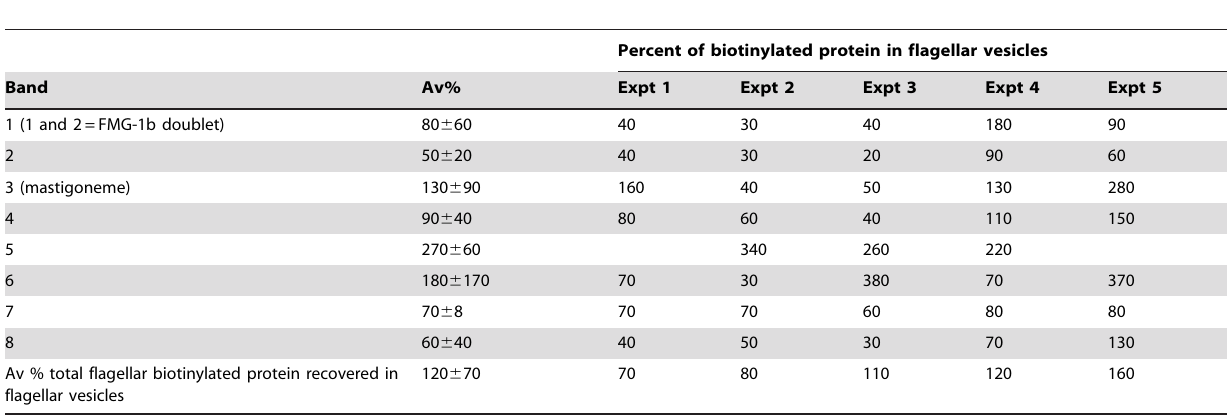
Table 1. Percentage of biotinylated flagellar protein bands recovered in flagellar vesicle fractions after 6 hr